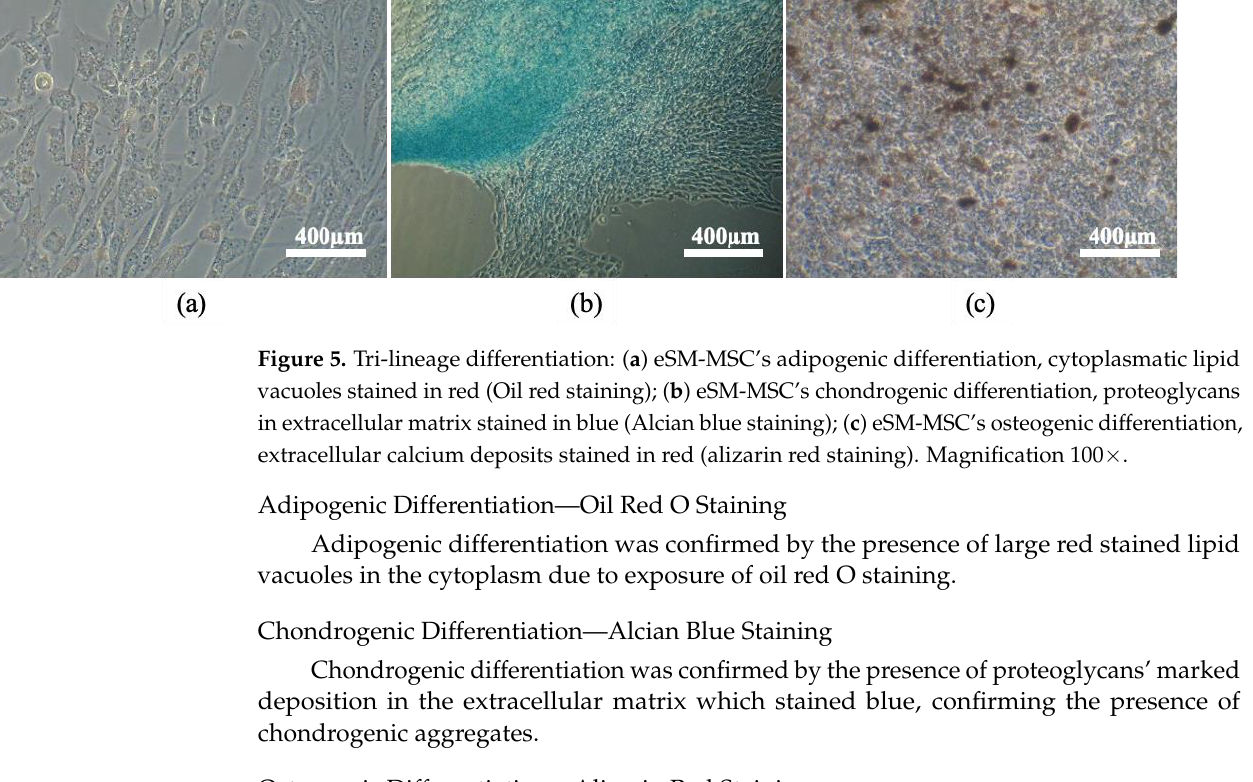
Table 6. Cytogenetic analysis in Passages 4 and 7 (P4 and P7). Percentage of normal cells, tetraploid cells, and aneuploid cells.